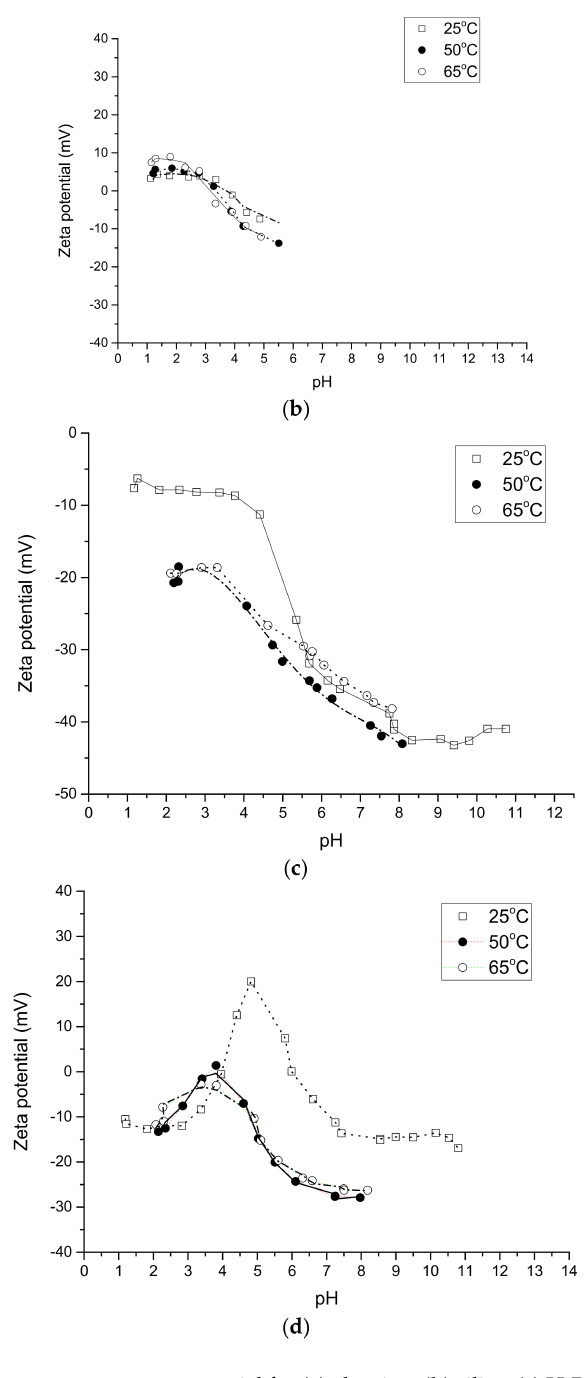
Figure 7. Effect of temperature on zeta potential for ( a ) alumina; ( b ) silica; ( c ) H-Beta-300; ( d ) H-Beta-25. Conditions: 2